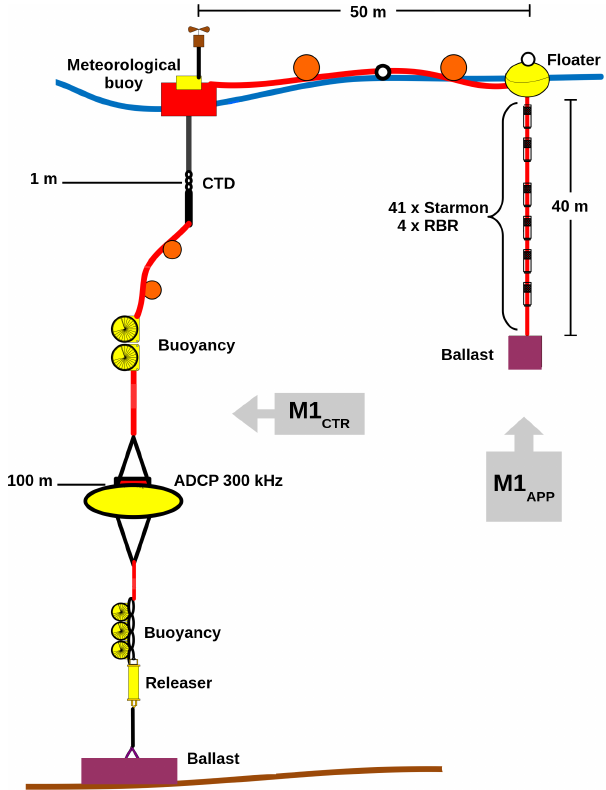
Figure 3. Design drawing of mooring M1. For explanations, see